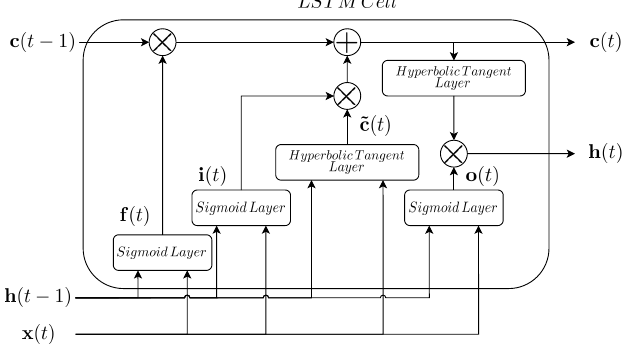
Figure 2. LSTM cell internal